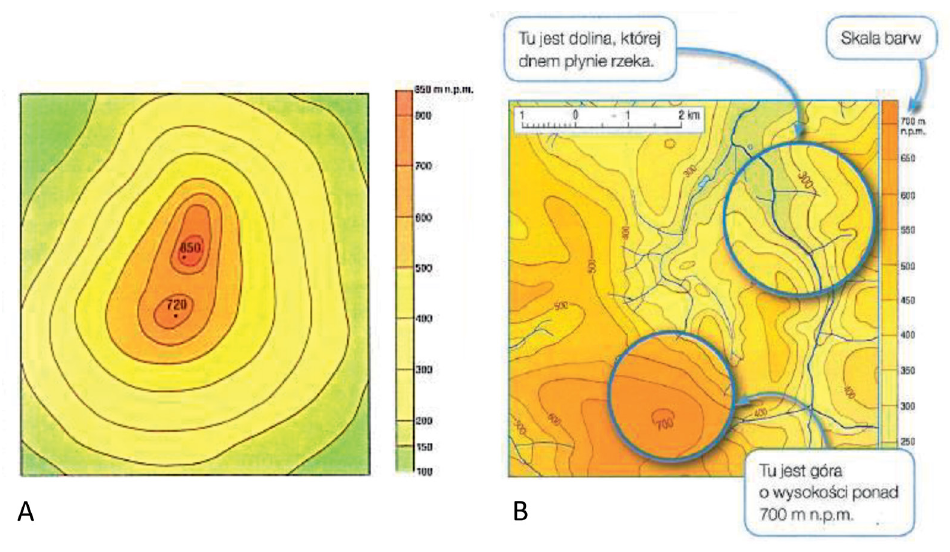
Fig. 6. Hypsometric map: A – in the textbook Tajemnice przyrody 5 (The secrets of nature 5) (P5), B – in the textbook Na tropach przyrody 6 (On the trails of nature 6)